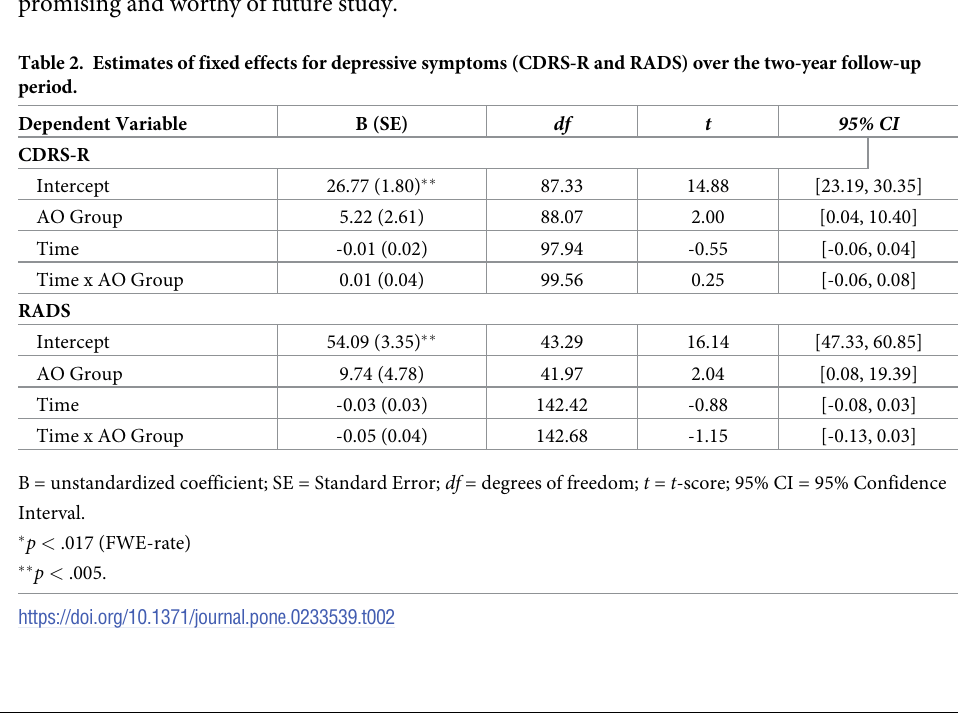
Fig 2. Clinical outcomes across two-years of longitudinal follow-up. Predicted means and standard errors derived from MRMs for the fMRI Completer sample. Baseline means and standard deviations are depicted for illustrative purposes and were not included in the MRM models. RFCBT = Rumination-focused Cognitive Behavior Therapy, AO = Assessment Only, RRS = Ruminative Response Scale, CDRS-R = Children’s Depression Rating Scale–Revised, RADS = Reynolds Adolescent Depression Scale. Panel a illustrates change in CDRS-R, panel b illustrates change in RADS, panel c illustrates change in RRS over two years.